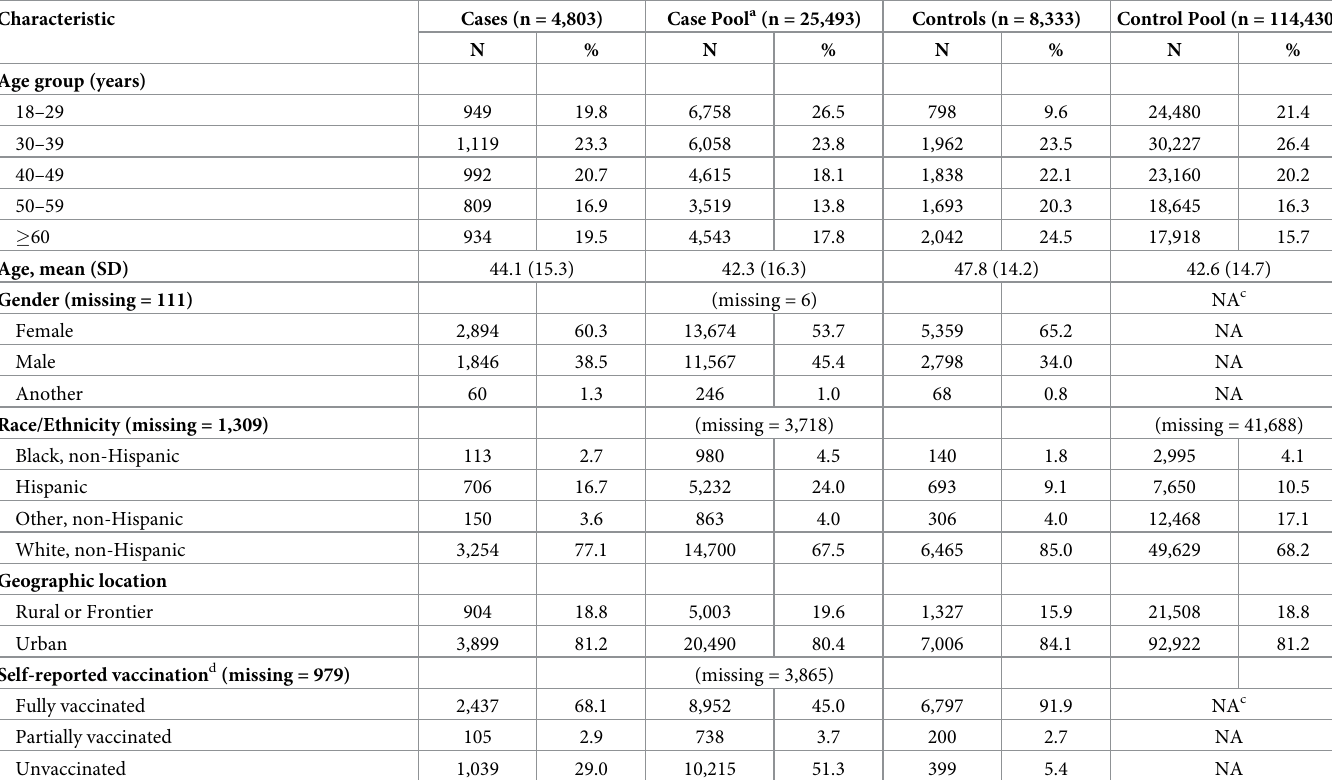
Table 1. Characteristics of symptomatic Colorado adults aged � 18 years with confirmed COVID-19 (enrolled cases) compared to persons testing negative for COVID-19 (enrolled controls) and the populations from which they were selected–specimen collection dates from March 16 to December 23, 2021.